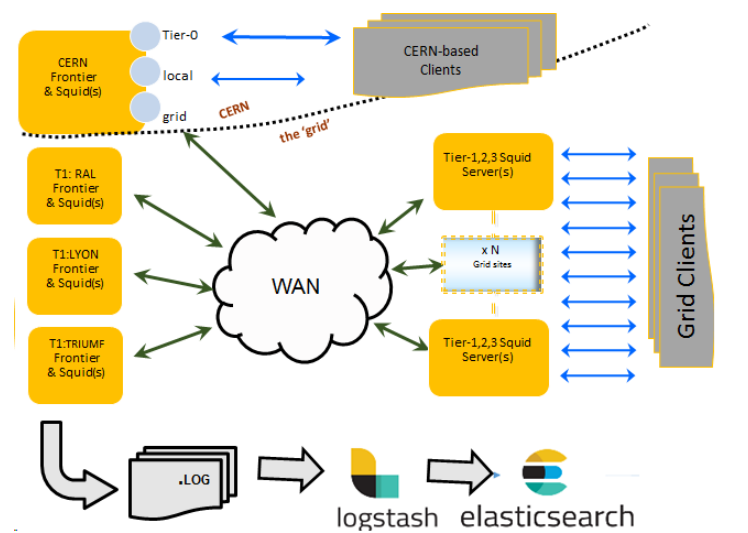
Figure 4. A schematic of global ATLAS Frontier deployment to serve the database needs of processing tasks across the world-wide ATLAS computing grid. Data from Frontier site log files are collected in an Elasticsearch repository which enables monitoring globally as well as studies of individual